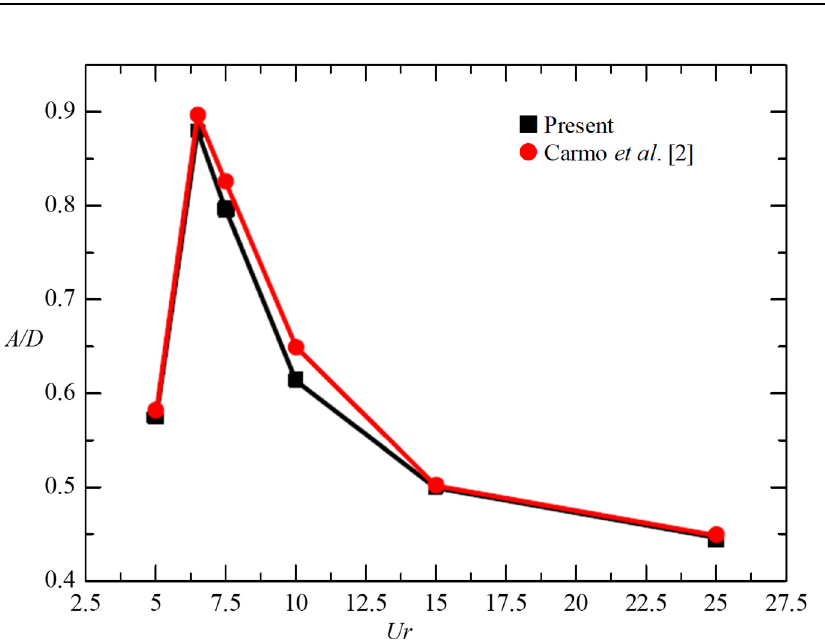
Figure 4. Validation of wake-cylinder vibration amplitude A/D plotted against reduced velocity Ur. L/D = 3, m * = 2, ζ = 0.003, and Re = 150.